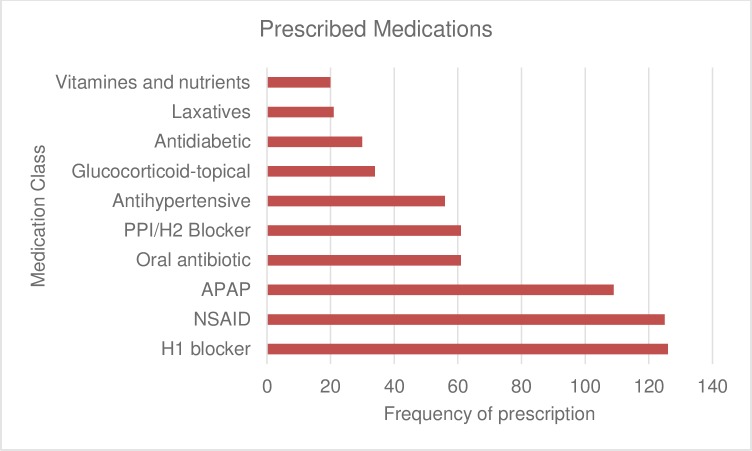
The most commonly prescribed medications at the SARHC.PPI/H2 Blocker: proton-pump inhibitor/Histamine receptor-2 blocker; APAP: acetaminophen; NSAID: non-steroidal anti-inflammatory; H1 blocker: Histamine receptor-1 blocker.